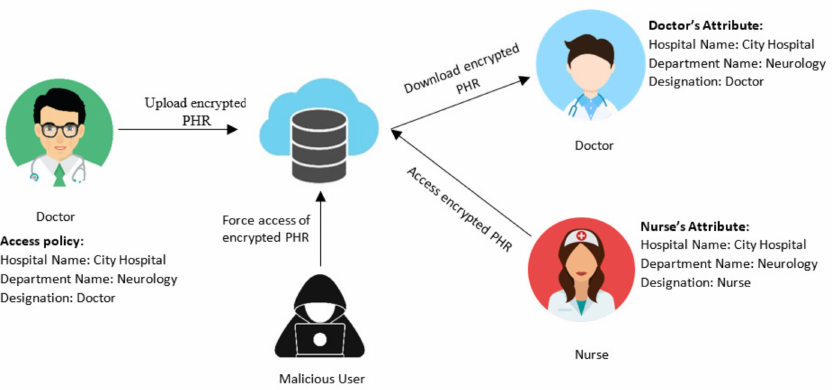
Figure 1. Sample Privacy Leakage